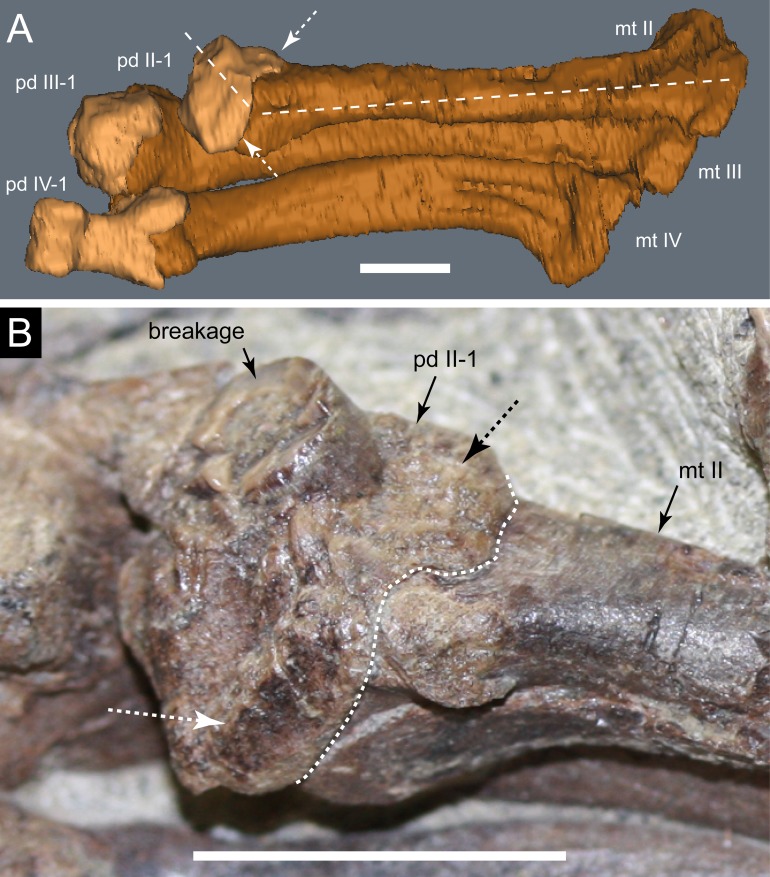
Diluvicursor pickeringi gen. et sp. nov. holotype (NMV P221080), potential pathologies of the right pes.(A) CT model of the pes in plantolateral view, with pedal digits I and V removed. (B) Metatarsophalangeal joint on pedal digit II in plantolateral view. Dashed lines in A indicate deflected axes between mt IV and pd IV-1. Dotted line in B indicates rugose bone on the proximal margin of pd IV-1. Dashed arrows in A–B indicate areas of osteophytosis (also see photographs, Figs. 19A and 19B). Abbreviations: mt #, metatarsal position; pd #, pedal digit number and phalanx position. Scale bars equal 10 mm.